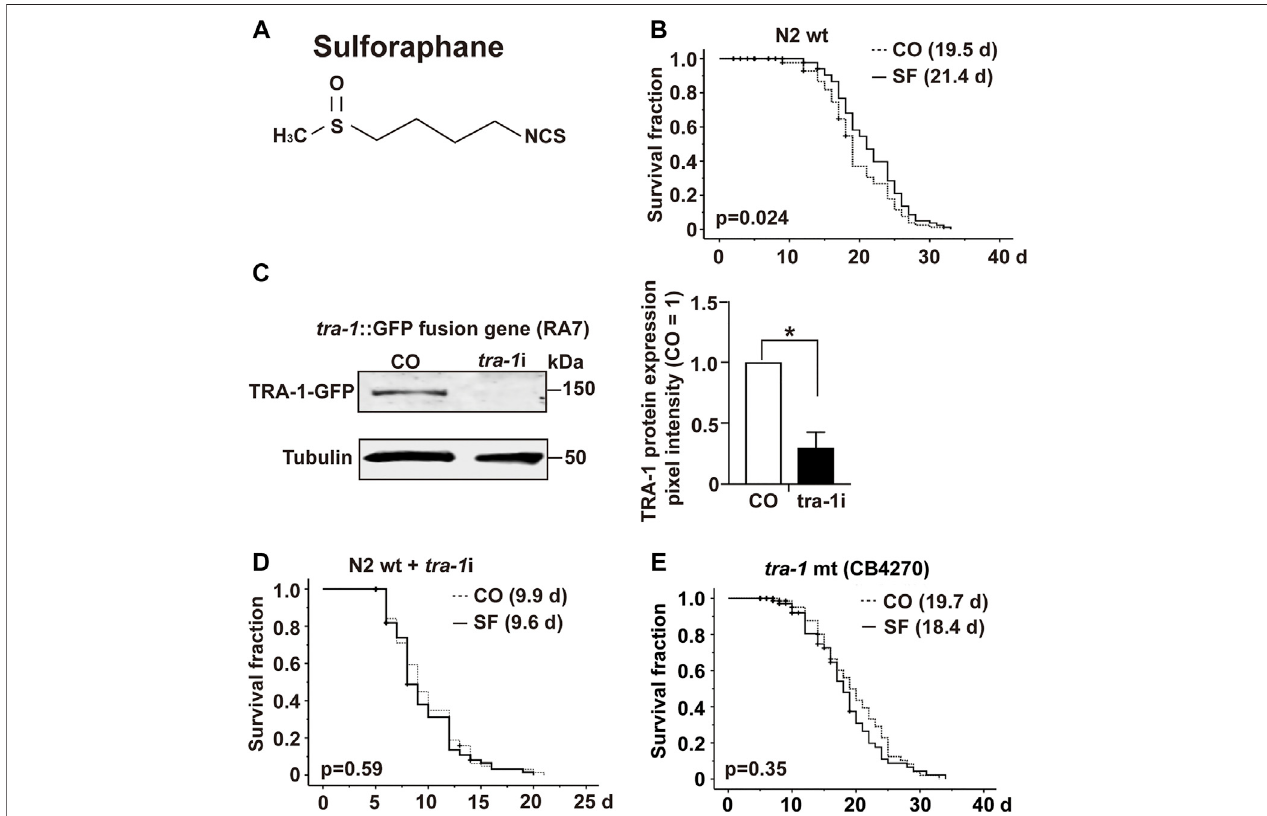
FIGURE 1 | TRA-1 is involved in sulforaphane-induced longevity. (A) Schematic representation of the chemical structure of isothiocyanate sulforaphane. (B) Synchronized N2 wild-type C. elegans L4 larvae ( n (cid:1) 100/group) were transferred to NGM plates and maintained at 20 ° C. In addition to the regular E. coli OP50 food bacteria, the culture plates contained 100 µM sulforaphane (SF) or not (CO). The lifespan assay started from the late L4 larval stage, which was considered Day 0 (0 days). FromDay 0toDay10,the C.elegans worms weretransferred tonewNGMplatesdaily. FromDay10,thewormsweretransferredeverysecondday.The endpoint was de fi ned as the day when all the worms were dead. In the Kaplan – Meier diagram, the numbers of living and censored worms are shown, and the log-rank testwasusedtoevaluatethestatisticalsigni fi cance. (C) Synchronized RA7 C.elegans L4larvaeharboringa tra-1 -GFPfusiongene( n (cid:1) 200/group)werefed tra-1 RNAi- transduced E. coli HT115 bacteria ( tra-1 i ) or nontransduced E. coli HT115 bacteria (CO). After 48 h, proteins were extracted, followed by Western blot analysis. A GFP- speci fi c antibody was used to target the GFP part of the TRA-1 fusion protein. Tubulin served as a control for equal loading conditions. The protein sizes in kilodaltons